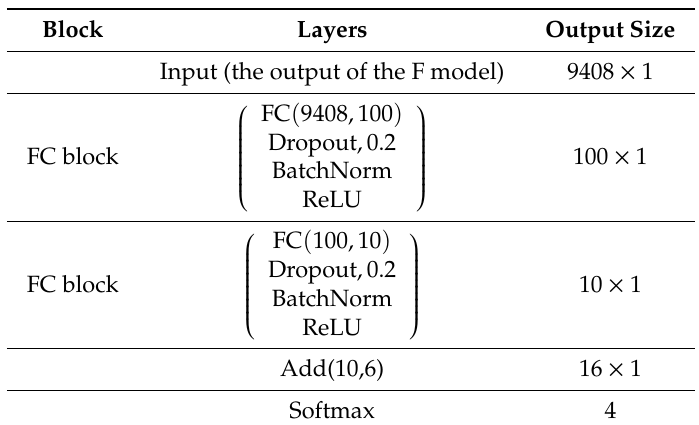
Table 5. A summary table of the C